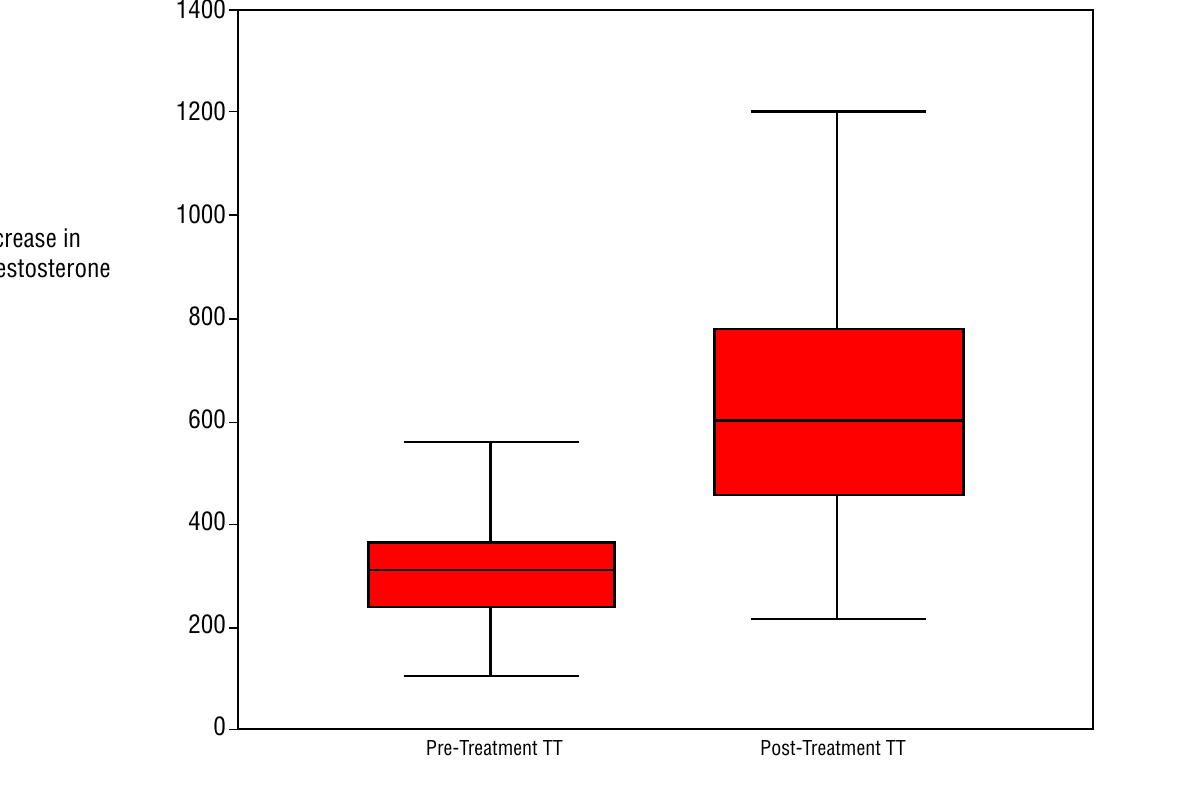
Figure 1 - Serum testosterone levels (ng/dL) pre and post treatment with clomiphene citrate, 25mg/day, in 125 hypogonadal men (values expressed between 5 and 95 percentiles and the